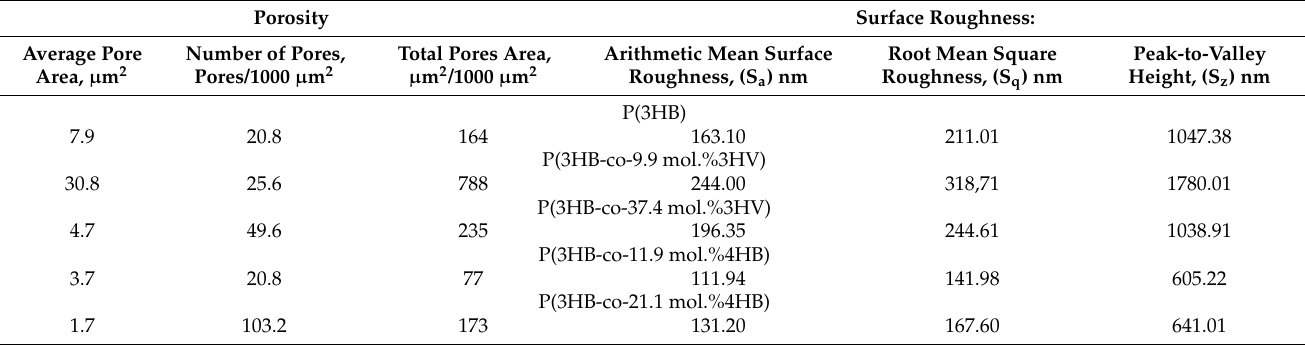
Table 6. Characterization of the films of PHAs synthesized from